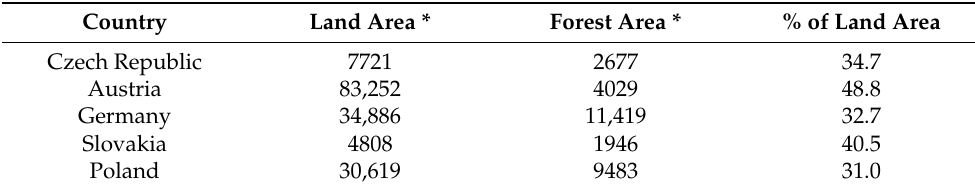
Table 1. Total area, forested area, and share of forest in selected Central European countries [13]. Country Land Area * Forest Area * % of Land